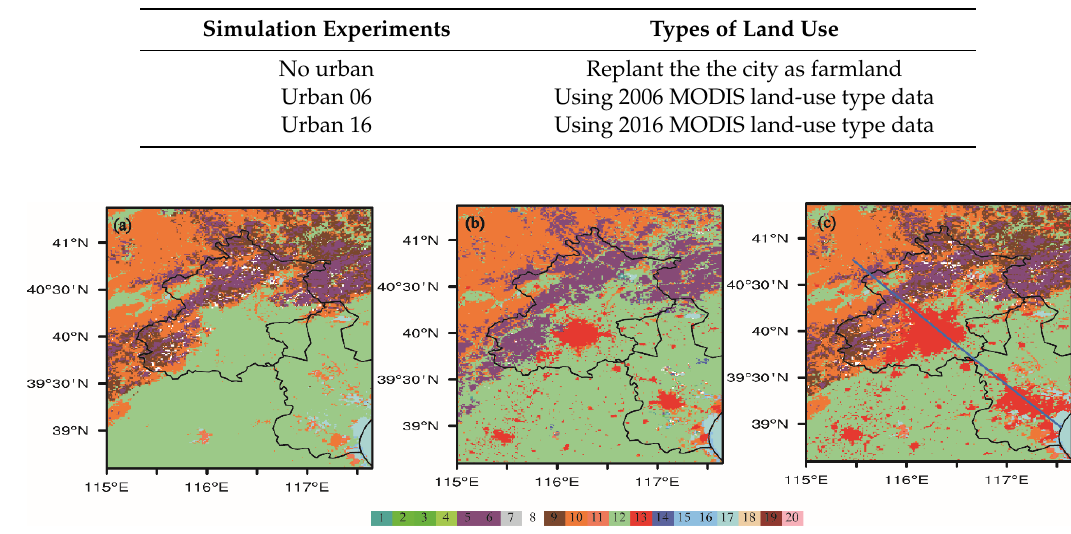
Figure 2. Land-use maps for D3 for the three experiments using the WRF/BEP model. ( a ) No urban